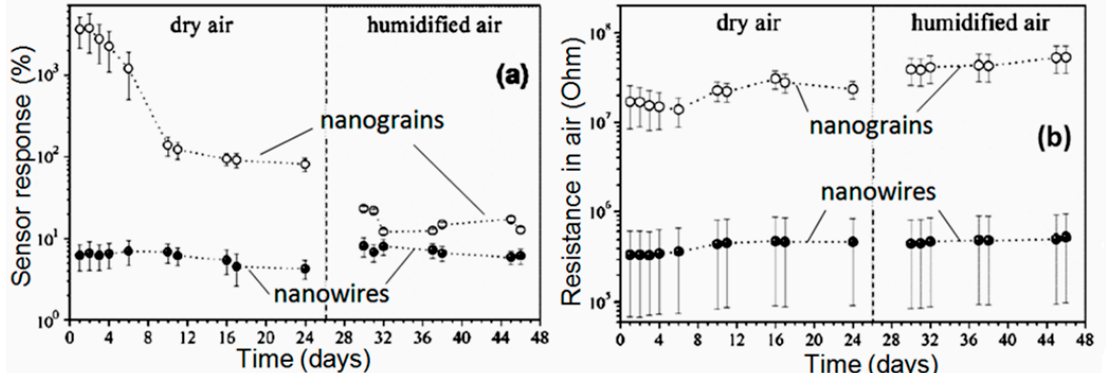
Figure 21. The change of sensing characteristics of the median sensor segment of a SnO 2 3D mesoporous nanoparticle (NP) or nanograins (NG) layer and nanowire (NW) mat versus measurement day: ( a ) Sensitivity or response to 1 ppm of 2-propanol vapors; ( b ) background resistance in air. Open and filled circles correspond to the NP and NW samples, respectively. Reproduced with permission from Sysoev et al. [129]. Copyright 2009: Elsevier.